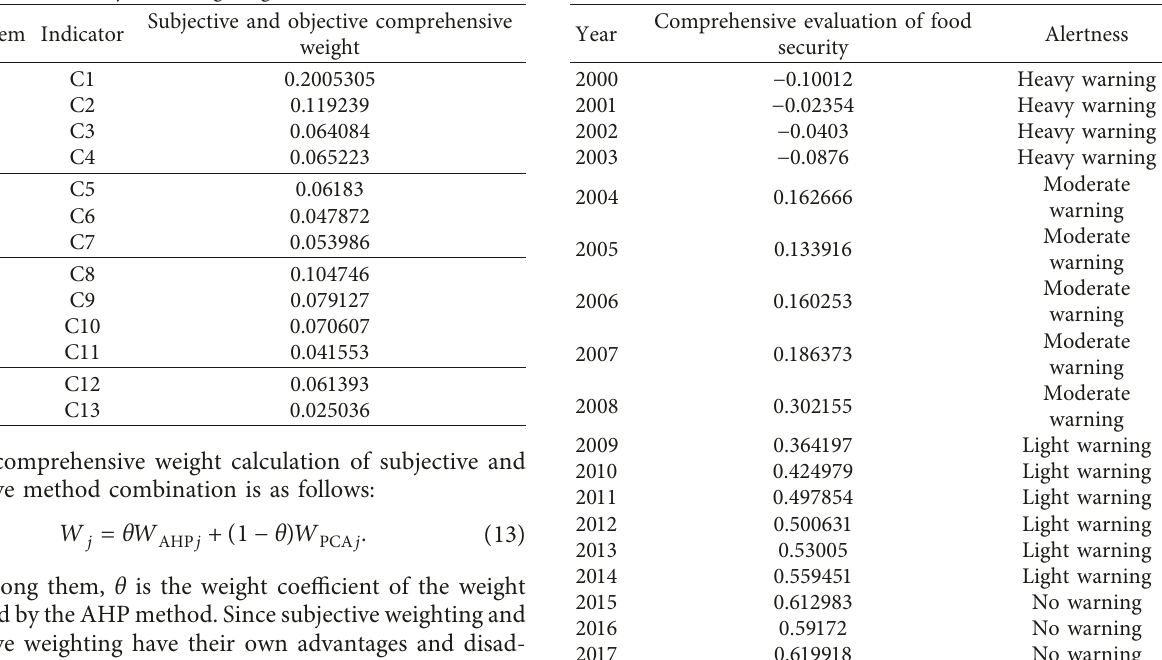
Table 4: Comprehensive weights of early warning indicators based on subjective and objective weighting.